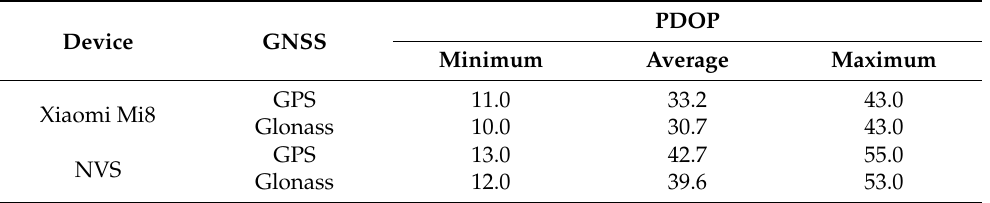
Table 3. Comparison between Xiaomi Mi8 and NVS